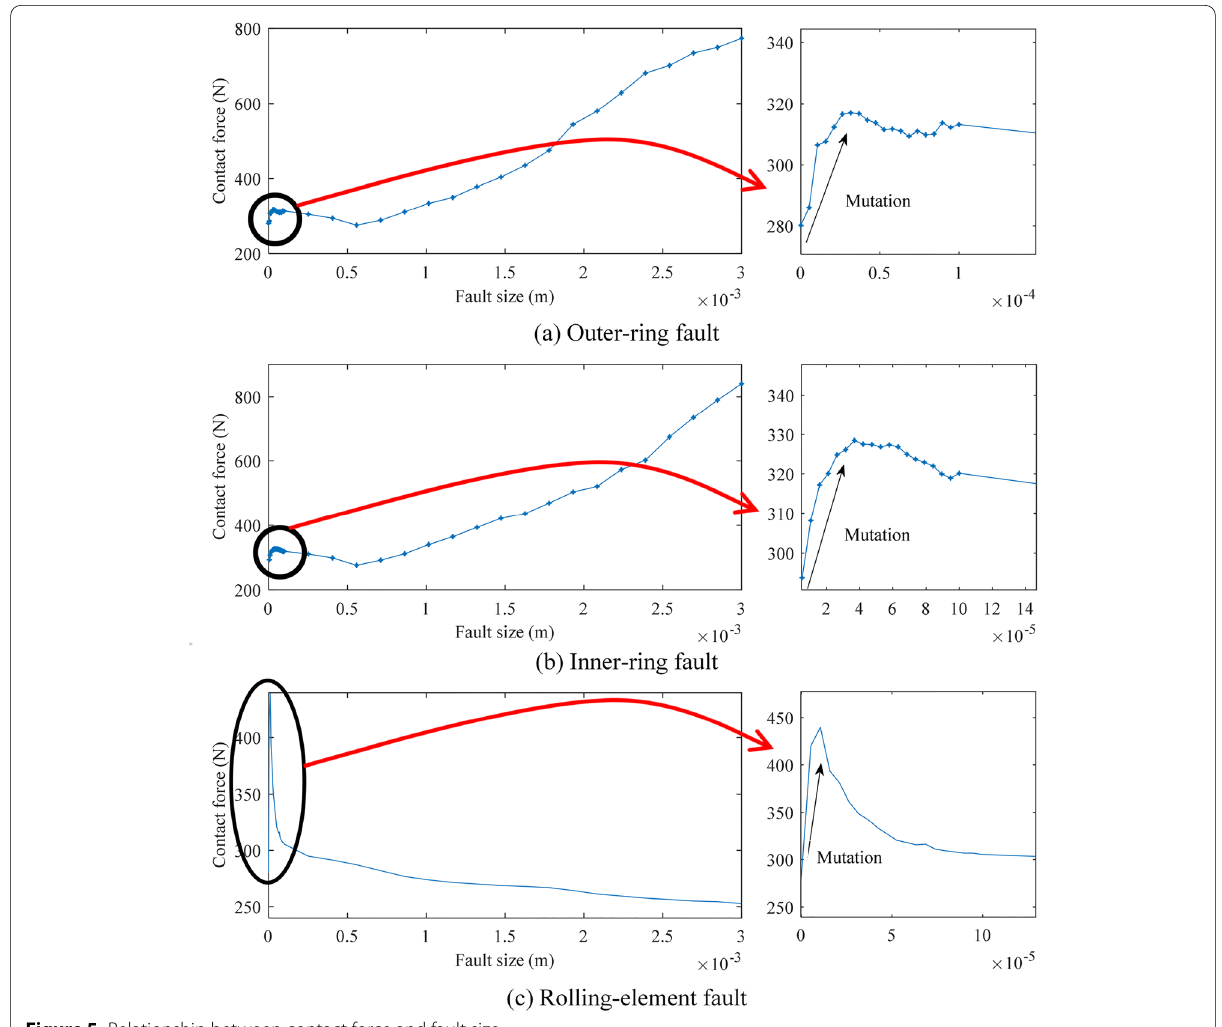
Figure 5 Relationship between contact force and fault